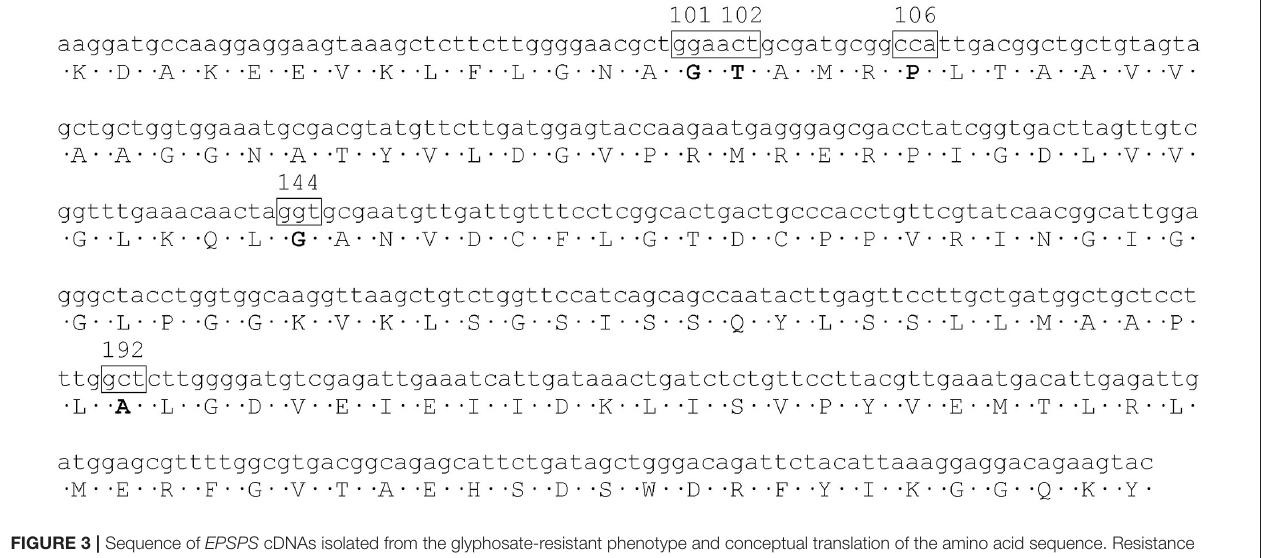
FIGURE 3 | Sequence of EPSPS cDNAs isolated from the glyphosate-resistant phenotype and conceptual translation of the amino acid sequence. Resistance conferring codons are show in boxes (numbers refer to amino acid positions in the EPSPS plant sequence according to Padgette et al. (1996). No mutations were detected in positions reported as sources of glyphosate resistance.